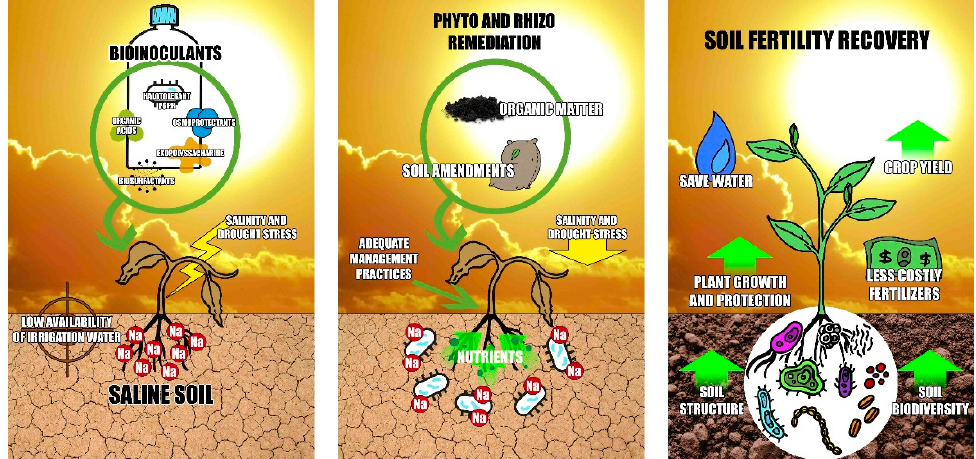
Figure 2. Application of halobacteria and their metabolites to recover soil fertility and increase crop yield in soils degraded by salinity and drought.